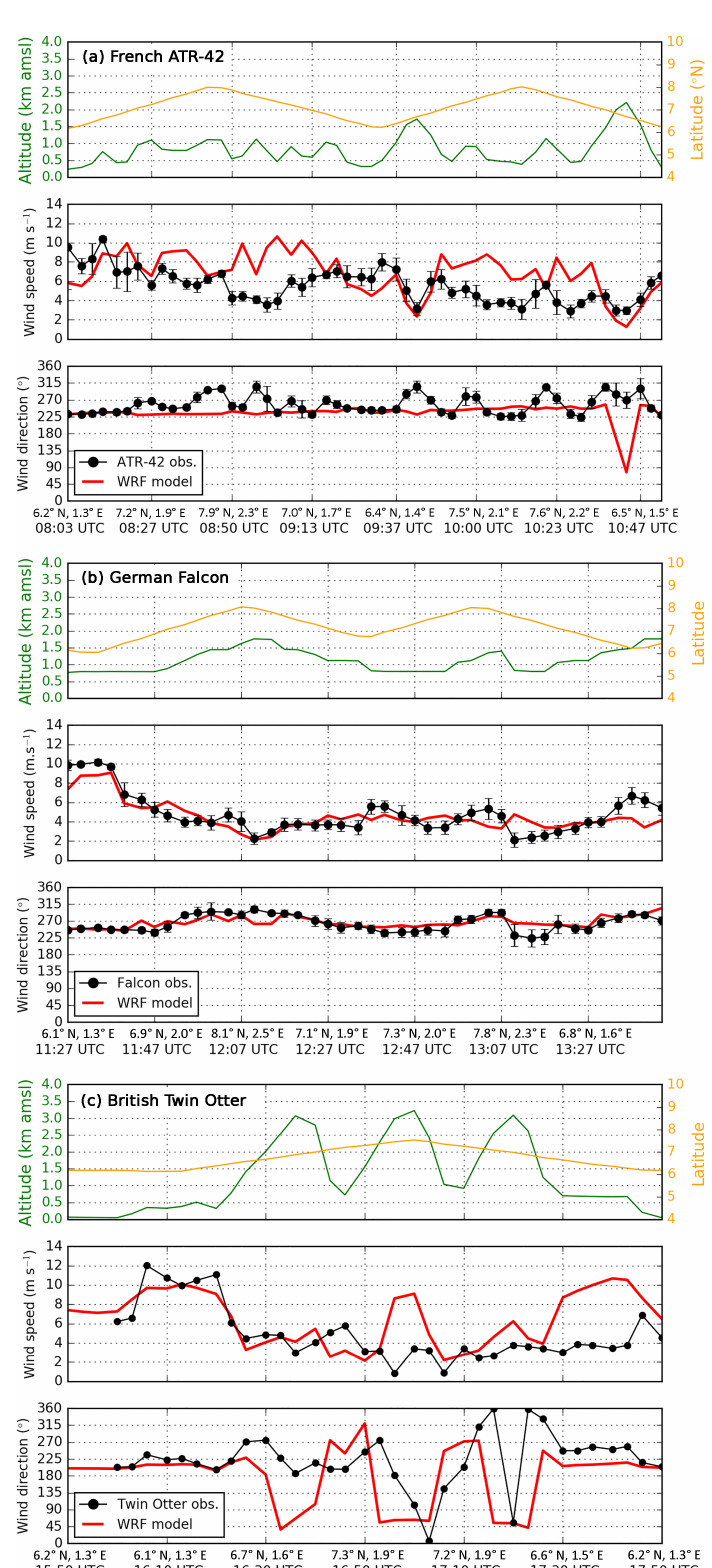
Figure 4. Time series on 5 July 2016 of (a) the French ATR 42, (b) German Falcon, and (c) British Twin Otter aircraft data, composed of three panels for each aircraft: (top) altitude (m) with the latitude ( ◦ N), (middle) wind speed (ms − 1 ), and (bottom) wind direction (degrees). Modeled values with the WRF model are interpolated along the flight positions (red line). Observed value averages are the black dots with the hourly standard deviation (error